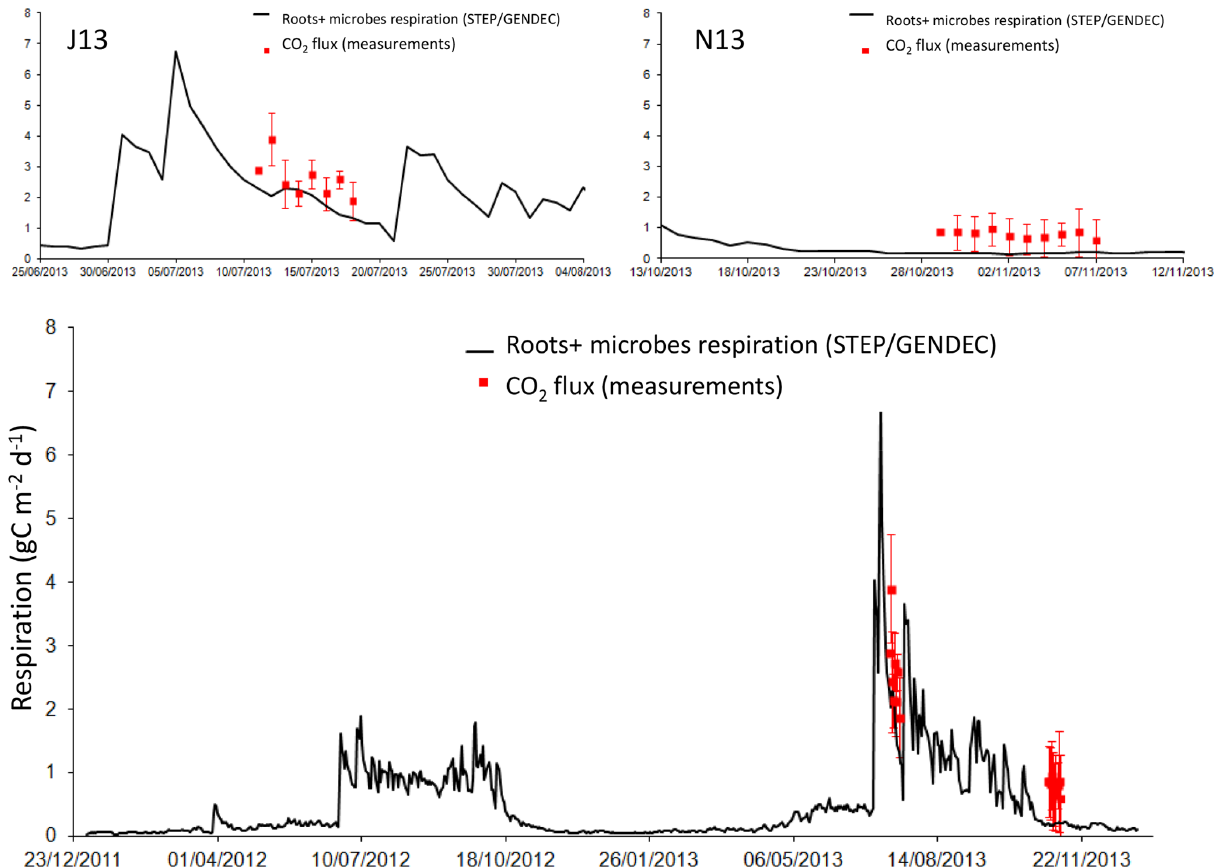
Figure 7. Daily root and microbe respiration in milligrammes of carbon per square metre per day simulated by STEP–GENDEC (black line), and daily averaged soil respiration measurements (red squares) during two field campaigns. Error bars in red give the standard deviation at the daily scale. The upper panels show a focus of J13 and N13 field campaigns.